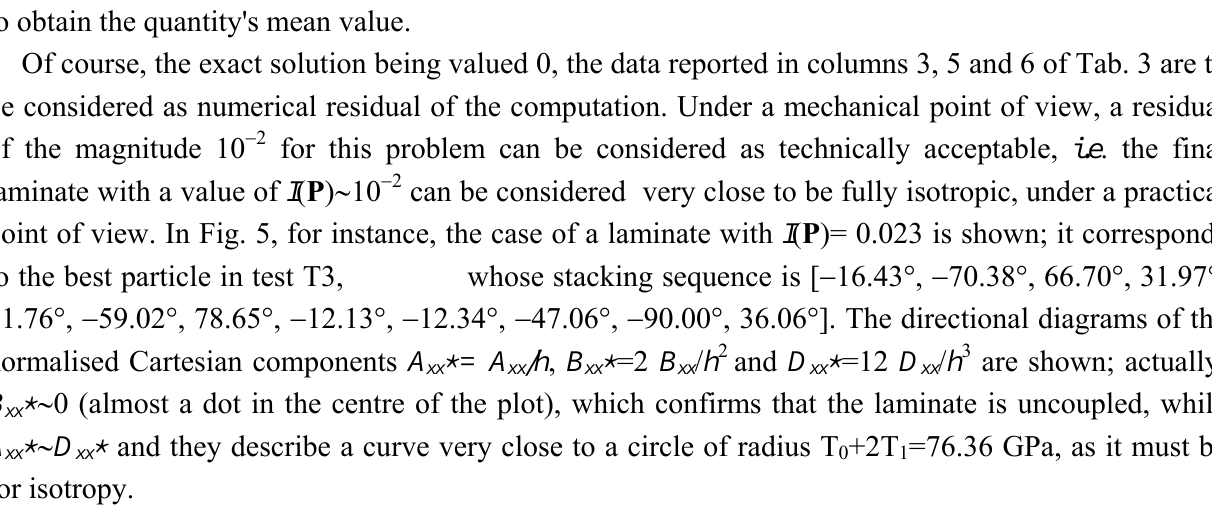
Table 3. Results of the tests T1 to T5 for example